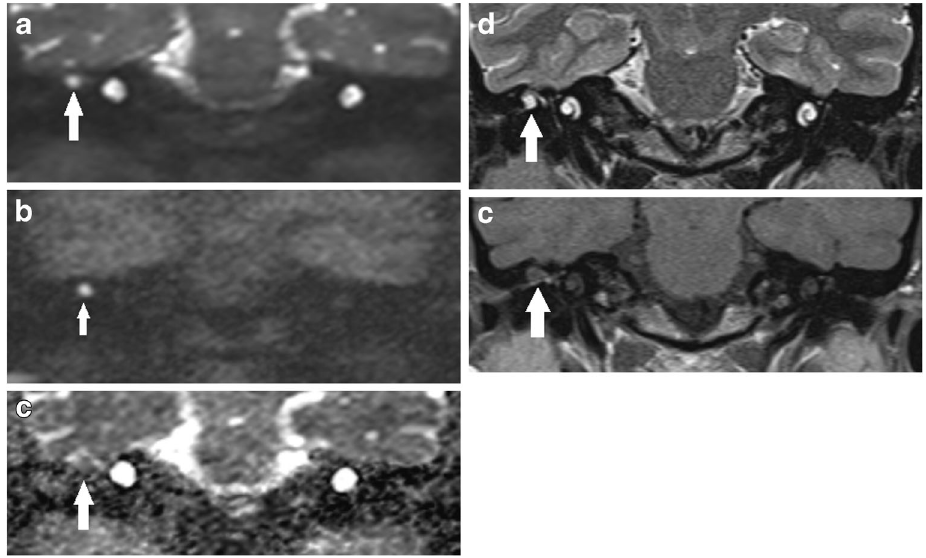
Fig. 3 DWI appearance of a small residual cholesteatoma confirmed on second-look surgery. The a b0 and b b1000 image shows a small 5 mm high signal cholesteatoma ( white arrow ) at the right epitympanum. It returns low signal on c the corresponding ADC map, high signal on d the T2 weighted image and low signal on e the non-contrast enhanced T1 weighted